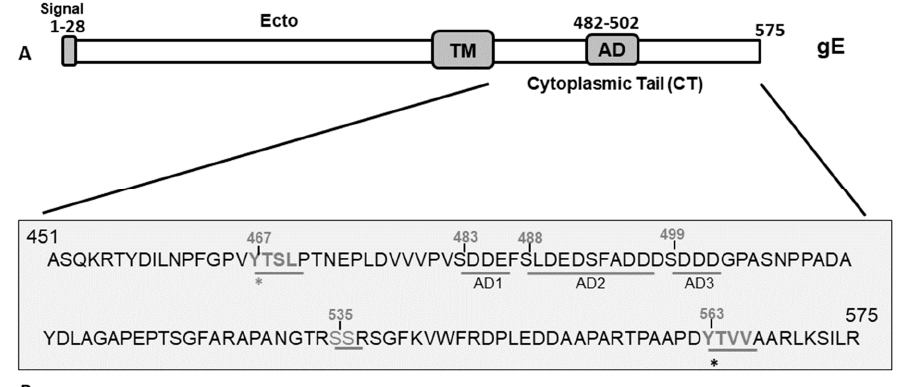
Figure1. ( A )SchematicdiagramshowingtheBHV-1gEproteinanditssubdomains. ThegEextracellular (Ecto), transmembrane (TM), cytoplasmic tail, and acidic (AD) domains are marked. ( B ) Predicted amino acid sequence spanning the gE CT region of BHV-1 (residue 451–575) showing the two tyrosine (Y)-based YXXL / YXX Φ motifs ( 467 YTSL 470 and 563 YTVV 566 ), serine (S) residues, and an acidic residue cluster (aa 483–502) shown in three sequential segments, AD1, AD2, and AD3, that correspond to the deletion mutants in Figure 2. The gE and its surrounding genes of various gE CT mutants used in this study to elucidate the functional role of gE CT motifs in BHV-1 anterograde neuronal transport were analyzed by sequencing. Further, the mutants were characterized with respect to cell-to-cell spread property, gE subcellular localization, and plaque sizes in non-neuronal cells